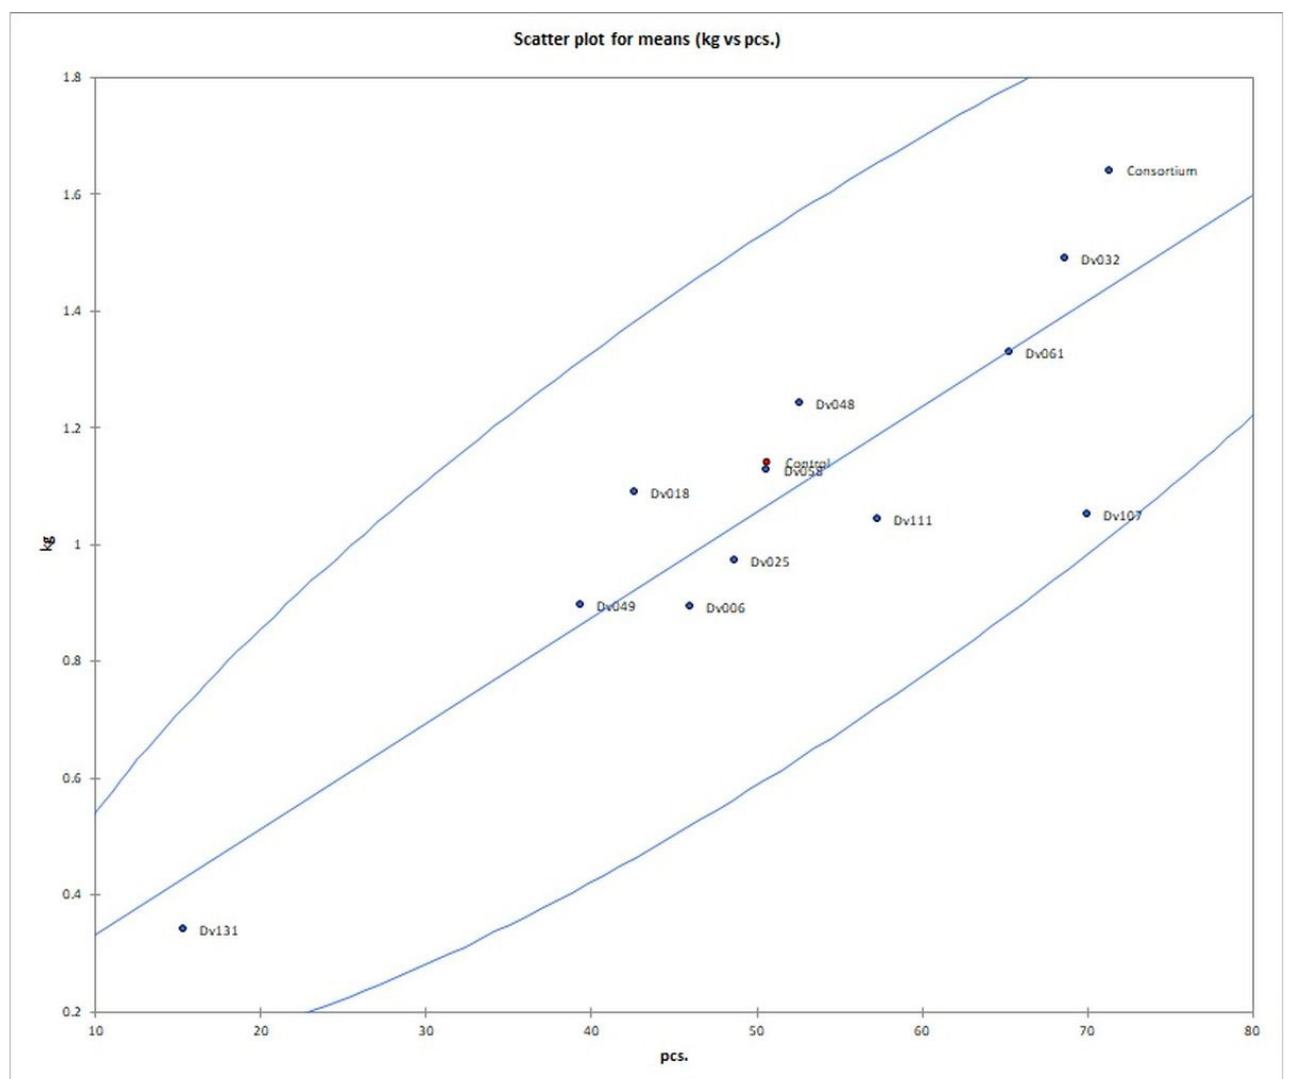
Figure 3. Scatter plot of number and mass yield of tomato fruits in each treatment. Red dot (Control) means negative control. means negative